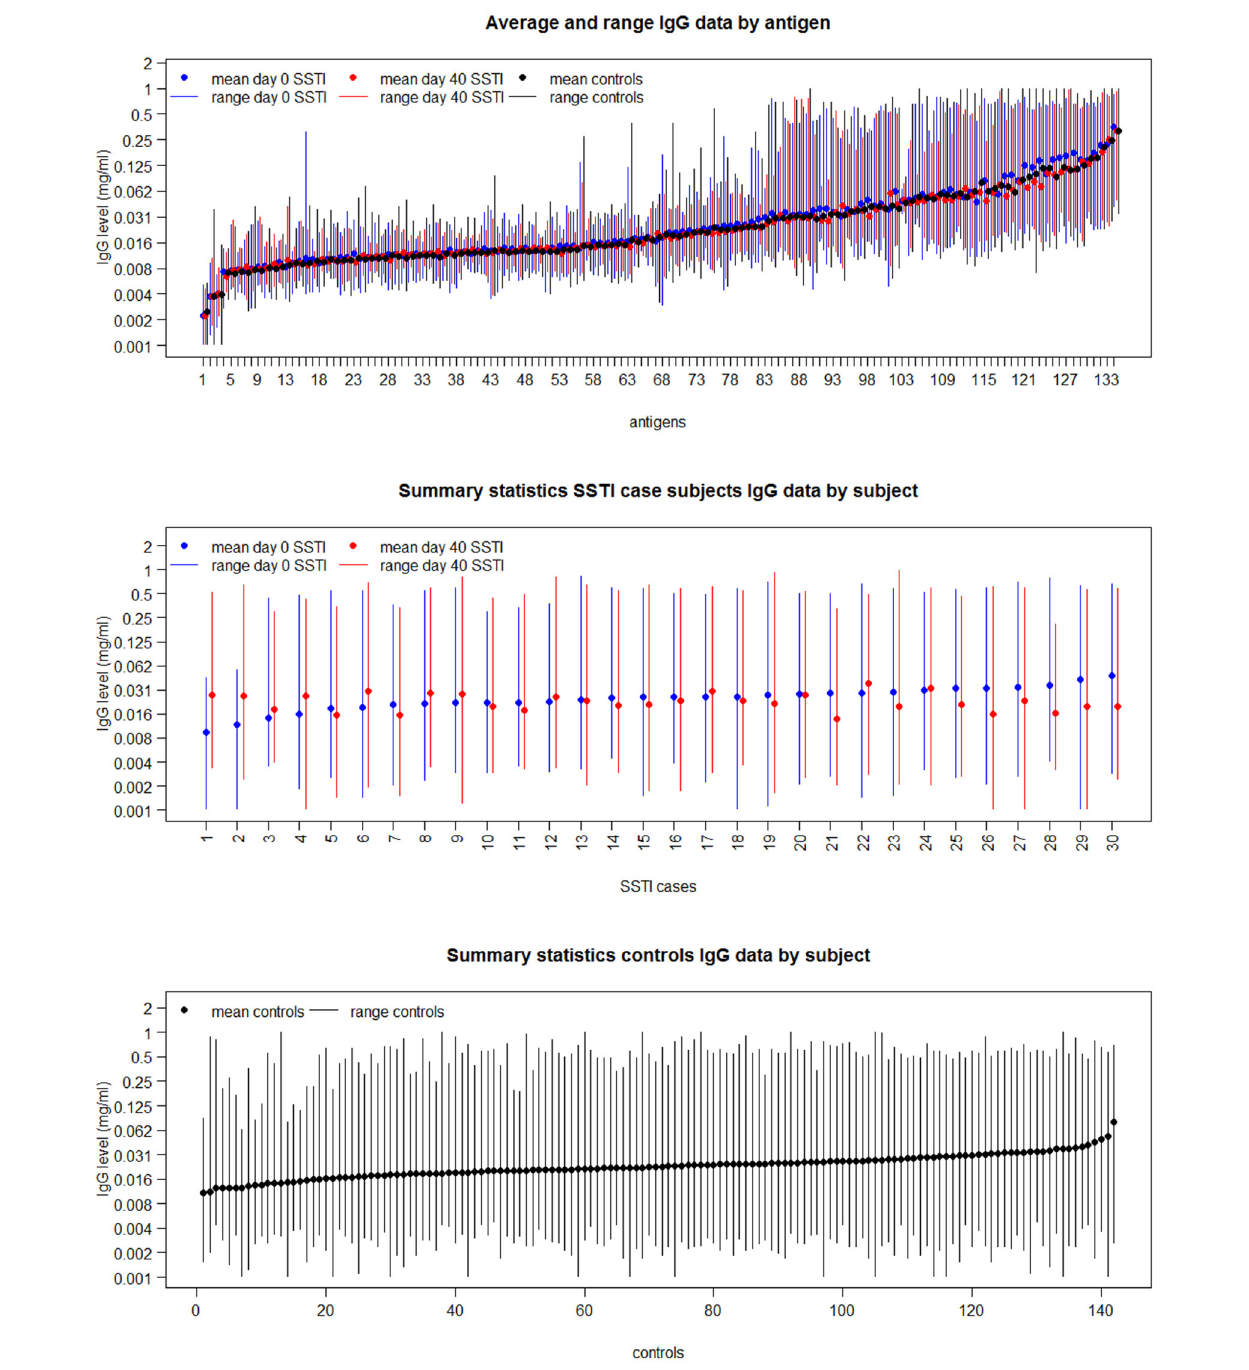
FIGURE 2 | The mean and range of IgG levels for each antigen calculated across case and control subjects ( Top ); and the mean and range of the 134 IgG levels for each of the 30 culture-confirmed S. aureus SSTI case subject serum samples ( Middle ) and for each control subject serum sample ( Bottom ).